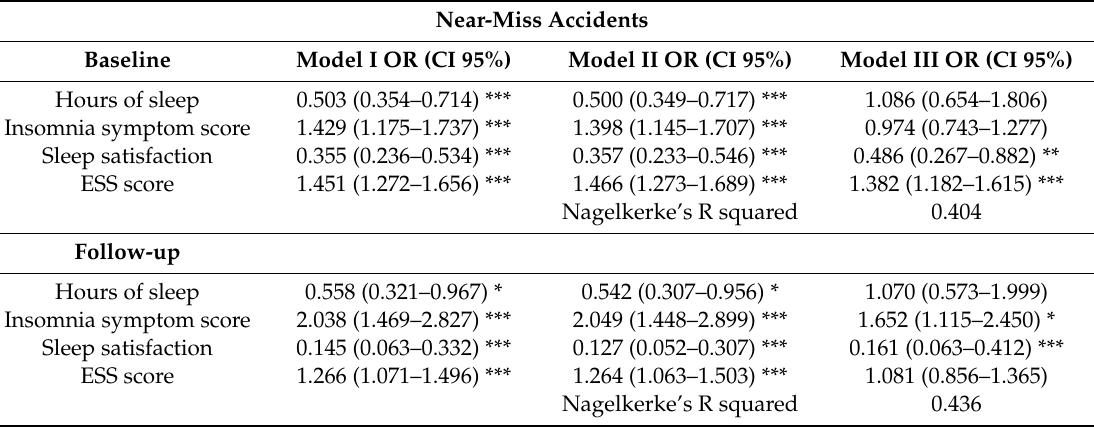
Table 4. Logistic regression analysis. Univariate association of sleep variables with near-miss accidents in police o ffi cers, at baseline and after the intervention (whole